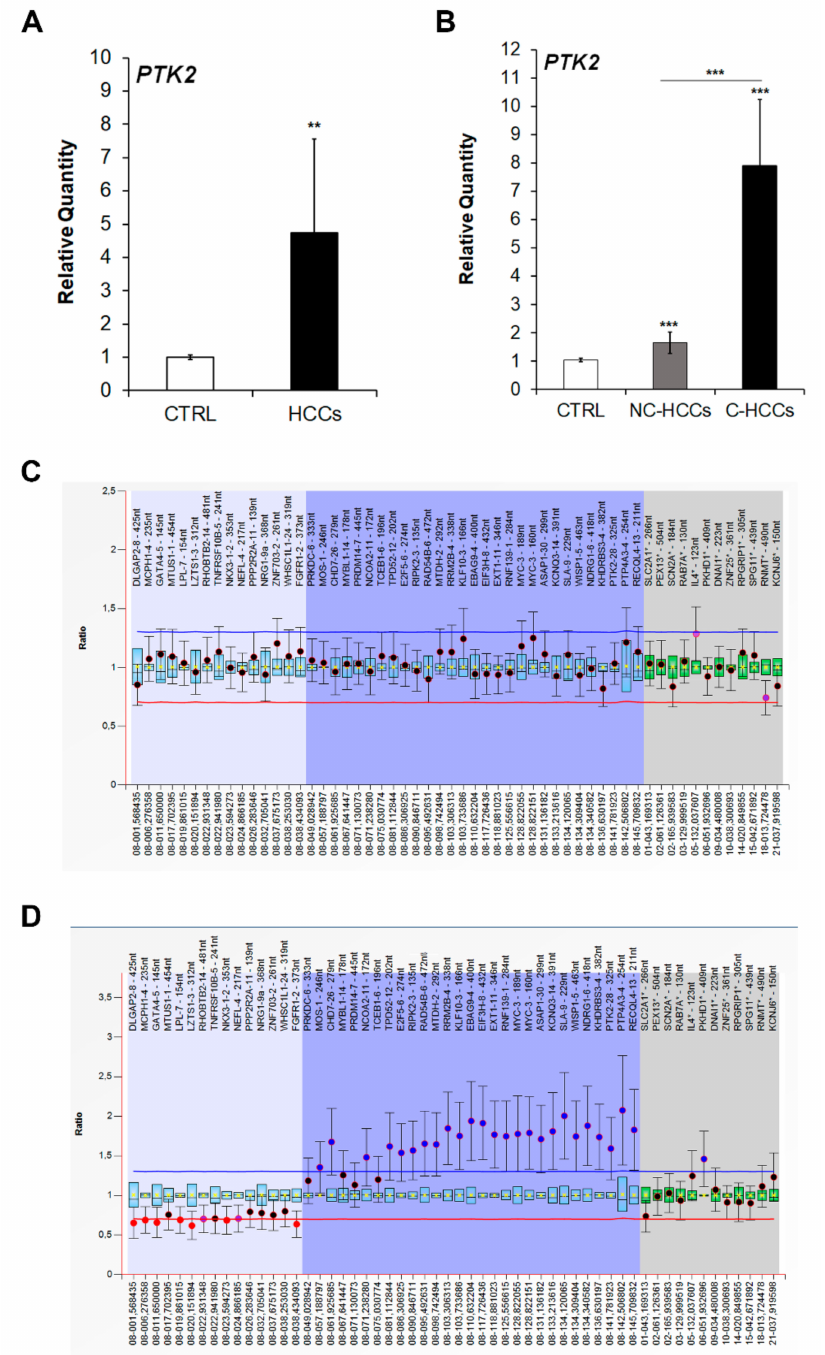
Figure 2. PTK2 over-expression and amplification in pediatric HCCs. Relative mRNA expression of PTK2 gene measured by qRT-PCR in all HCCs vs. CTRL samples ( A ), and in NC-HCCs and C-HCCs vs. CTRL samples ( B ). Normalization was performed with glyceraldehyde-3-phosphate dehydrogenase (GAPDH) mRNA levels. **, p < 0.01; ***, p < 0.001. MLPA ratio chart of NC-HCC ( C ) and C-HCC ( D